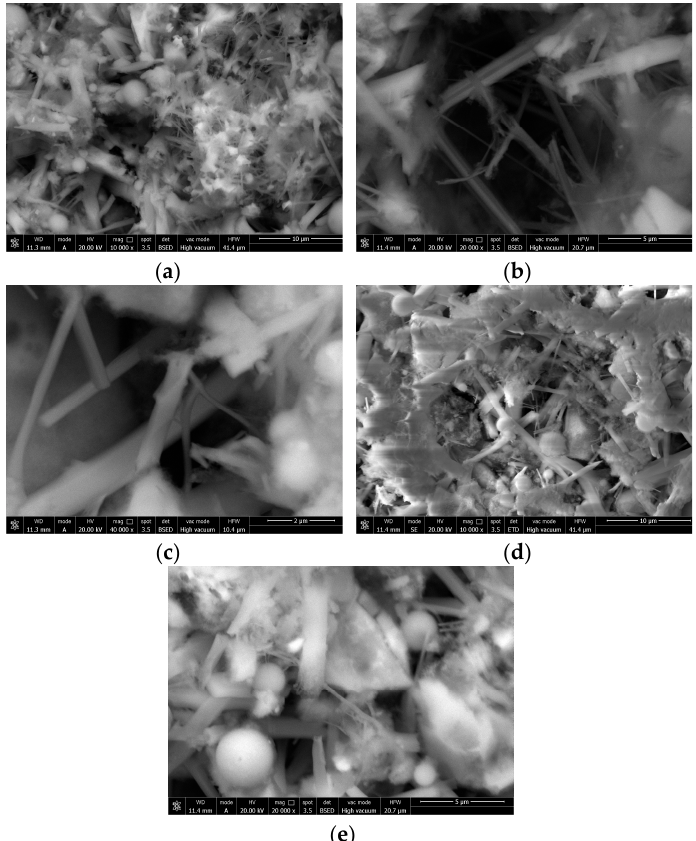
Figure 8. Microstructure of CNTs/foamed concretes with different magnification times. ( a ) 10 µm, ( b ) 5 µm, ( c ) 2 µm, ( d ) 10 µm, ( e ) 5 µm.